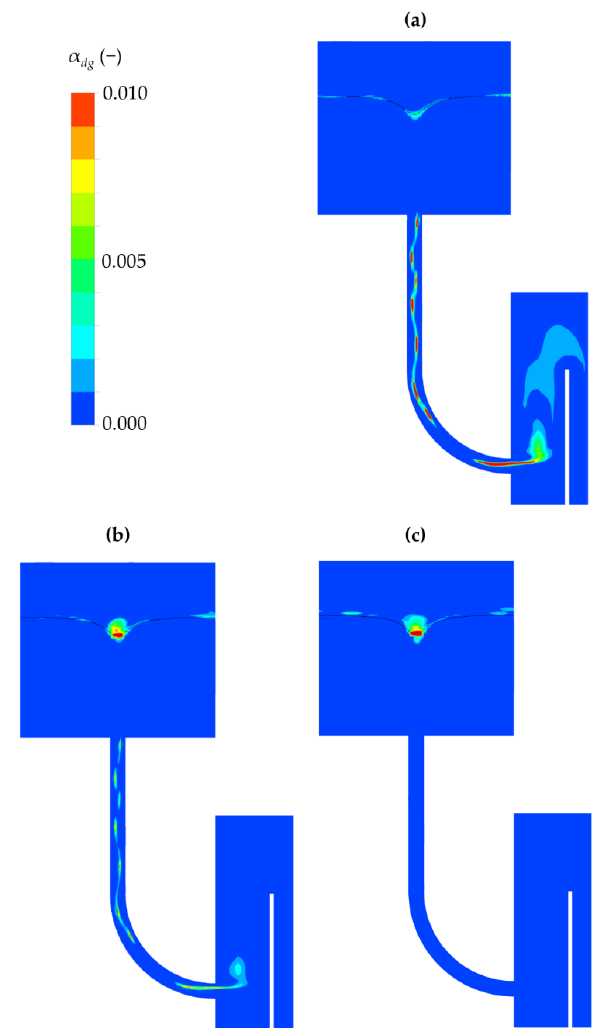
Figure 7. The contour of the dispersed gas fraction at t = 6 s plotted on the vertical central plane for the simulations of ( a ) Sim. A, ( b ) Sim. B, and ( c ) Sim. C. The results are obtained from the simulations using 𝐶 𝑒𝑛𝑡 = 2E-4 and 𝐶 𝑠𝑐𝑎𝑙𝑒 = 1.